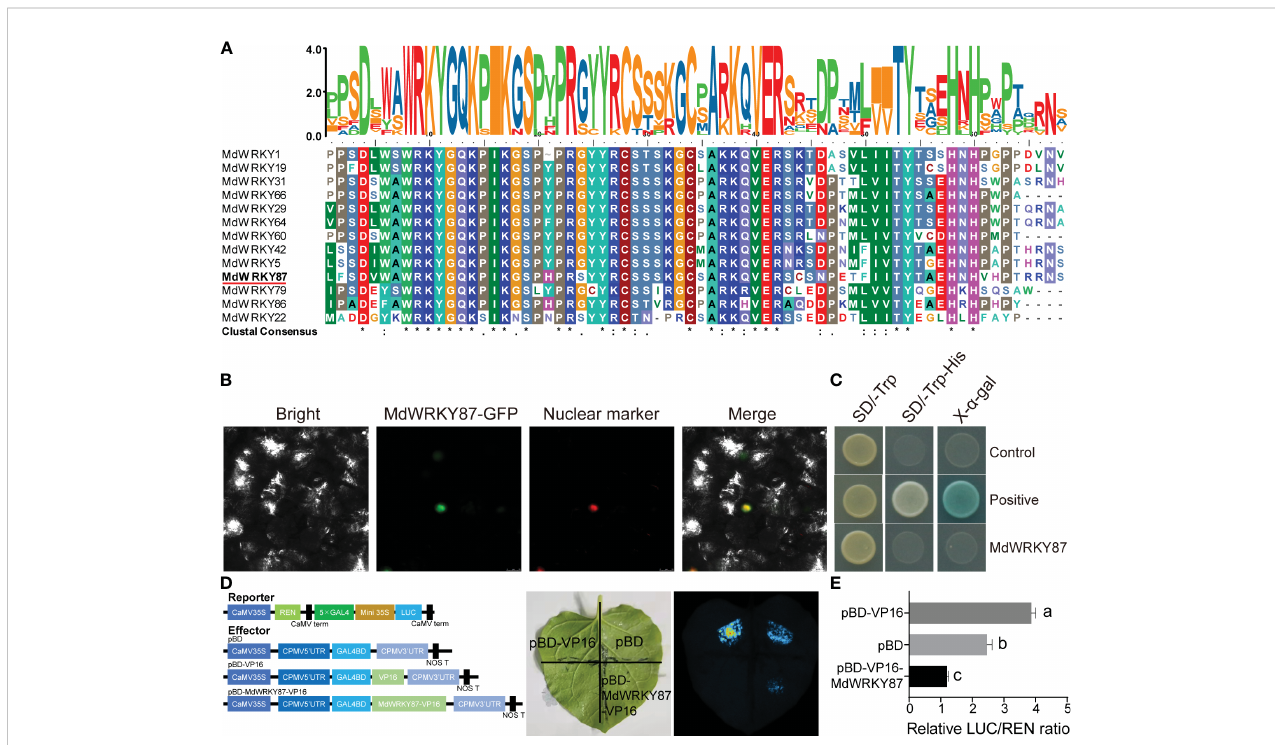
FIGURE 2 MdWRKY87 is a transcription repressor of WRKY family. (A) Sequence comparison of WRKY domains from WRKY IIe proteins, shaded by conserved amino acids. The accession numbers of all genes used are listed in the Methods section. (B) Subcellular localization of MdWRKY87 in N. benthamiana leaves. Agrobacterium carrying the pSuper : MdWRKY87-GFP and pSuper : NF-YA4-mCherry as a nuclear marker genes was co-in fi ltrated into N. benthamiana leaves. Images were captured 2 d following agroin fi ltration. (C) Transcriptional activity analysis of MdWRKY87 protein in yeast. The transactivation activity was veri fi ed by the growth of yeast AH109 harboring MdWRKY87 ORF on SD/-Trp and SD/-Trp-His plates and was con fi rmed by a X- a -Gal staining assay. (D) Transcriptional activity analysis of MdWRKY87 in N. benthamiana leaves. Reporter and effector constructs were co-in fi ltrated into N. benthamiana leaves. Left, schematic representation of the effector and reporter constructs. Right, live imaging of N. benthamiana leaves expressing reporter and effector constructs. (E) The dual-luciferase activity assay. The values were determined by calculating the ratio of LUC activity to REN activity (LUC/REN). Different letters indicate statistically signi fi cant differences ( P < 0.05) at by Duncan ’ s